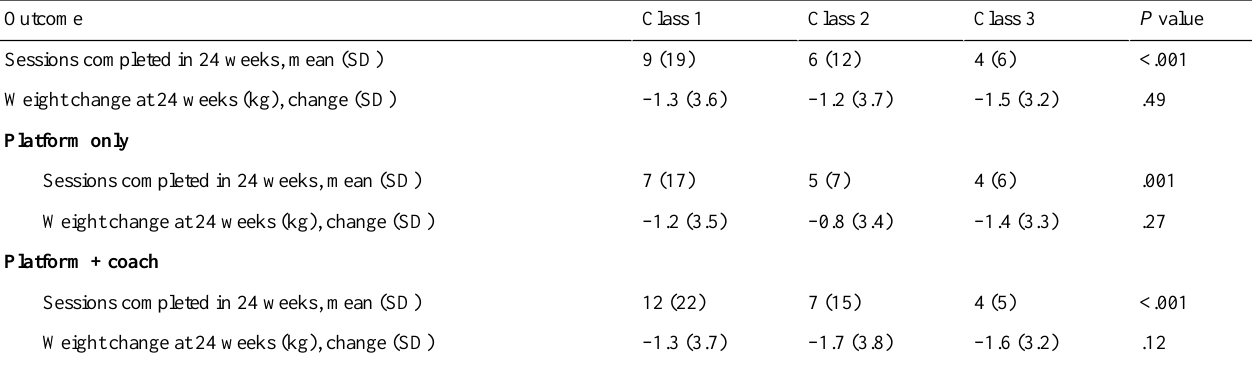
Table 4. Number of sessions and weight change at 24 weeks by class.